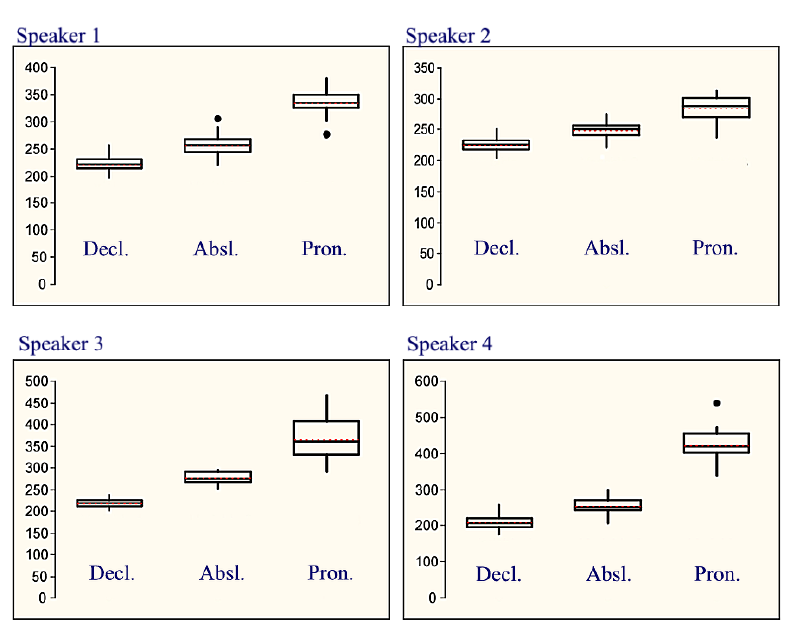
Figure 4. Box plots of prenuclear High tonal values for all speakers. Tonal values are based on raw Hz values.